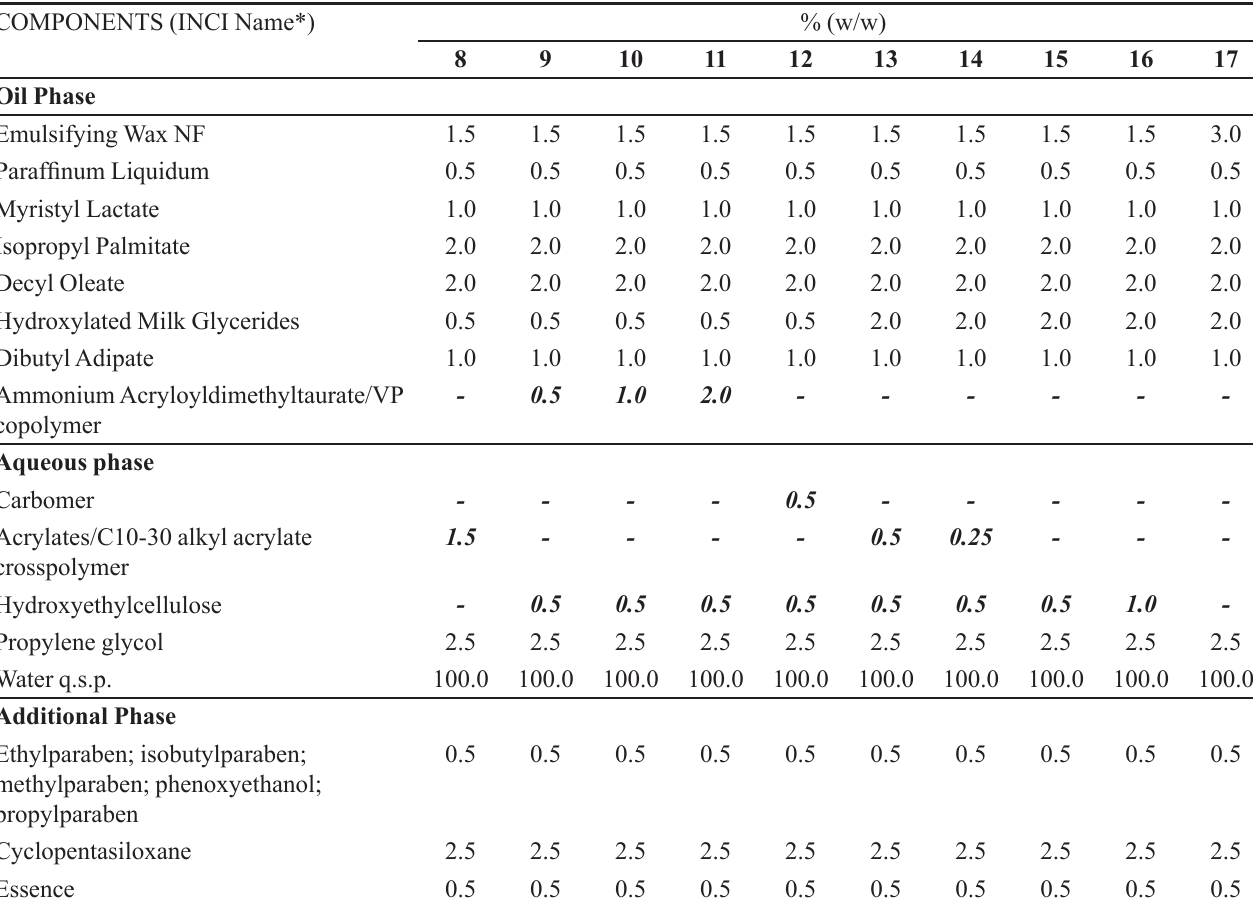
TABLE II – Qualitative and quantitative composition of the pre-formulations containing 0.8% of papain, prepared for macroscopic evaluation and sensorial aspect ( 8 to 17